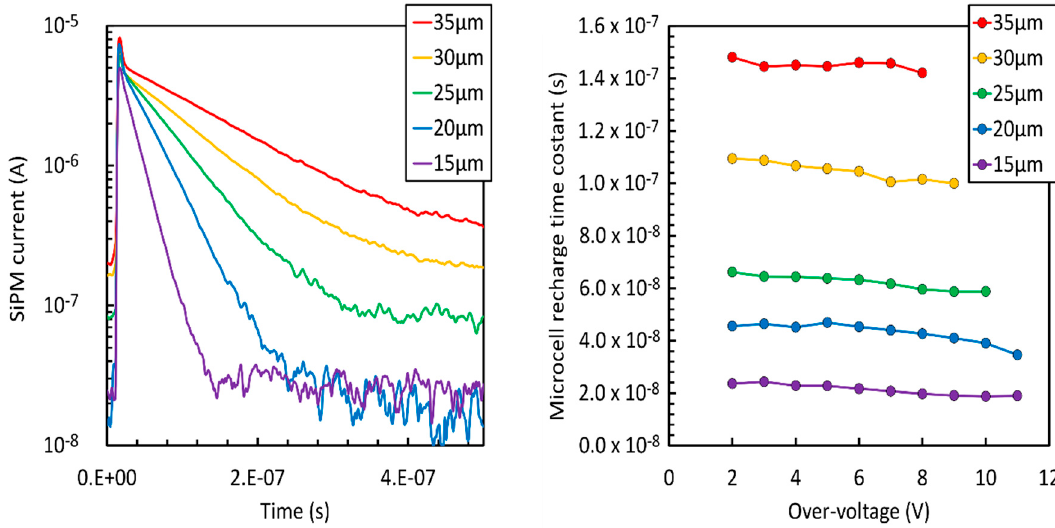
Figure 9. Left : Signal shape, in current, measured for all the cell sizes at 6 V overvoltage. Right : Recharge time constant, τ r , vs. overvoltage for all cells.